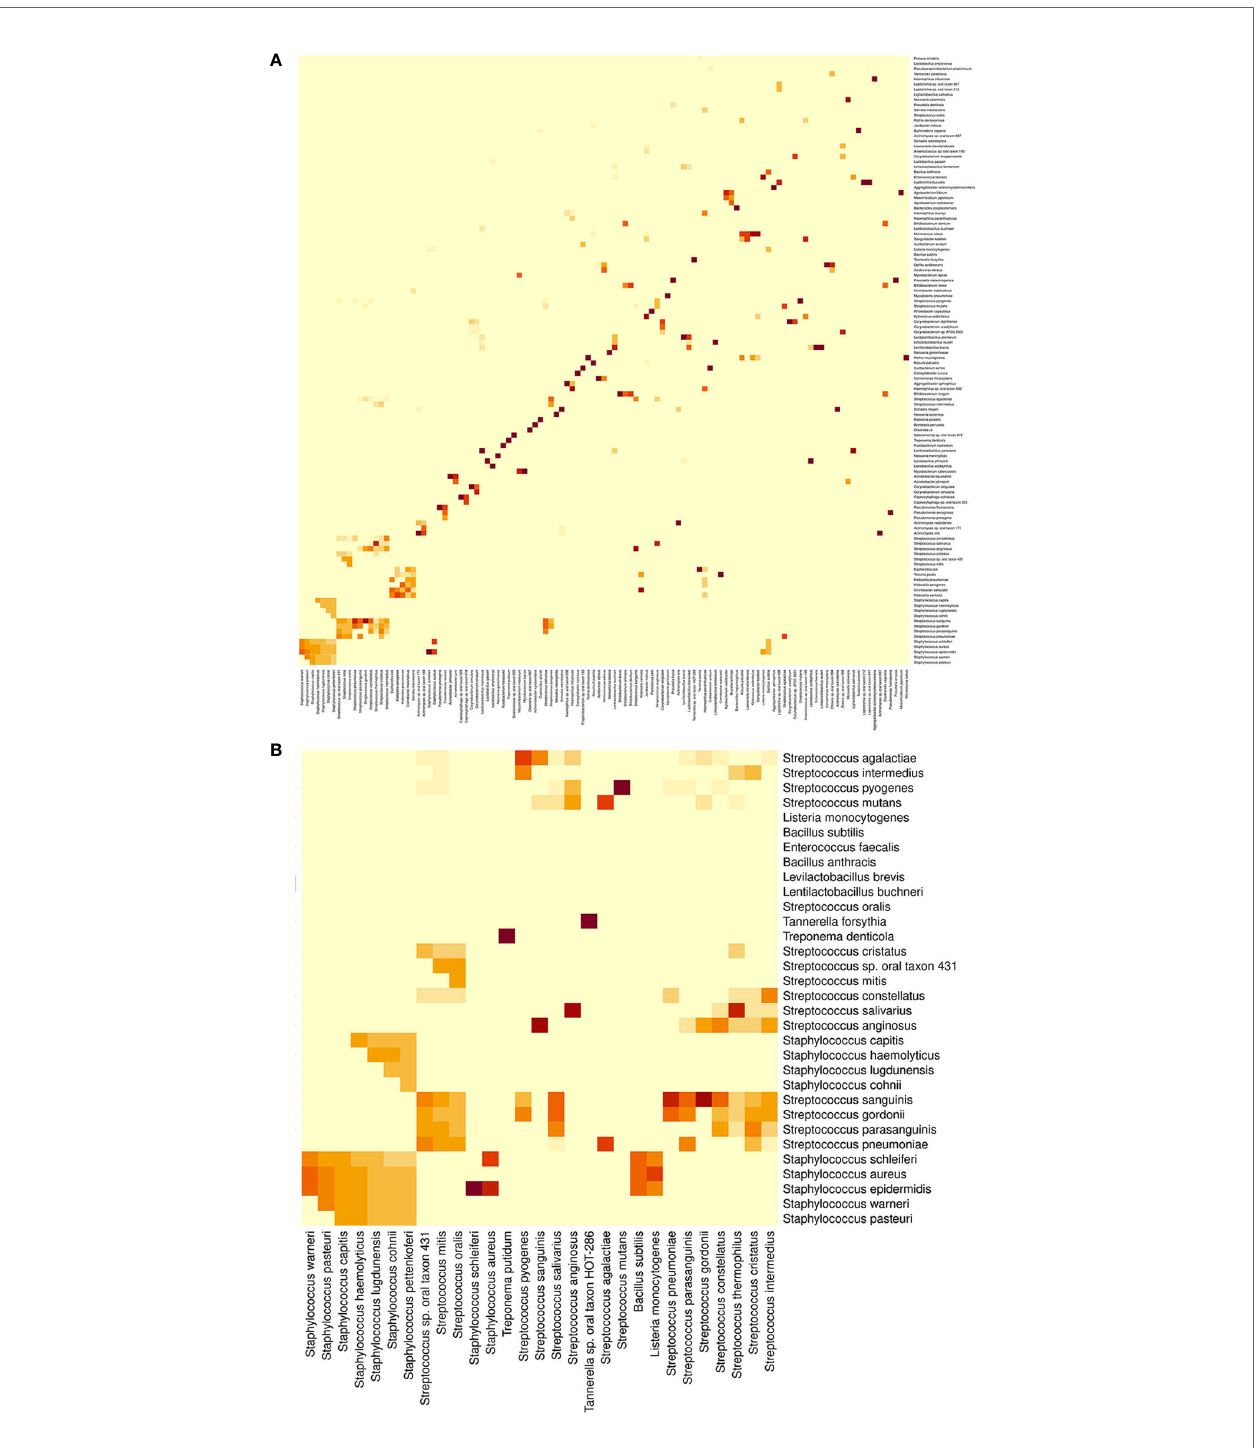
FIGURE 9 | Heat map showing the presence of in-silico amplicon similarity values ≥ 97% between pairs of different archaeal species. (A) Global perspective. (B) Partial perspective, involving species belonging to genera Methanosarcina , Pyrococcus , Staphylothermus , Thermococcus , and Thermoproteus . The intensity of the color indicates the frequency, i.e. the number of times a species pair had an in-silico amplicon similarity value ≥ 97% in the different primer pairs